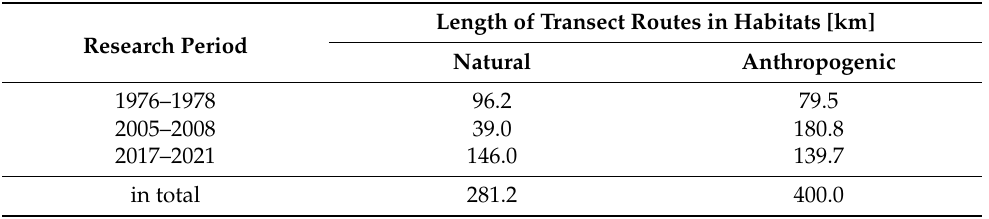
Table 1. The length of snow tracking transect routes to determine roe deer abundance in natural and anthropogenic habitats of Warsaw during three research periods (1976–1978, 2005–2008, 2017–2021). Length of Transect Routes in Habitats [km] Research Period Natural